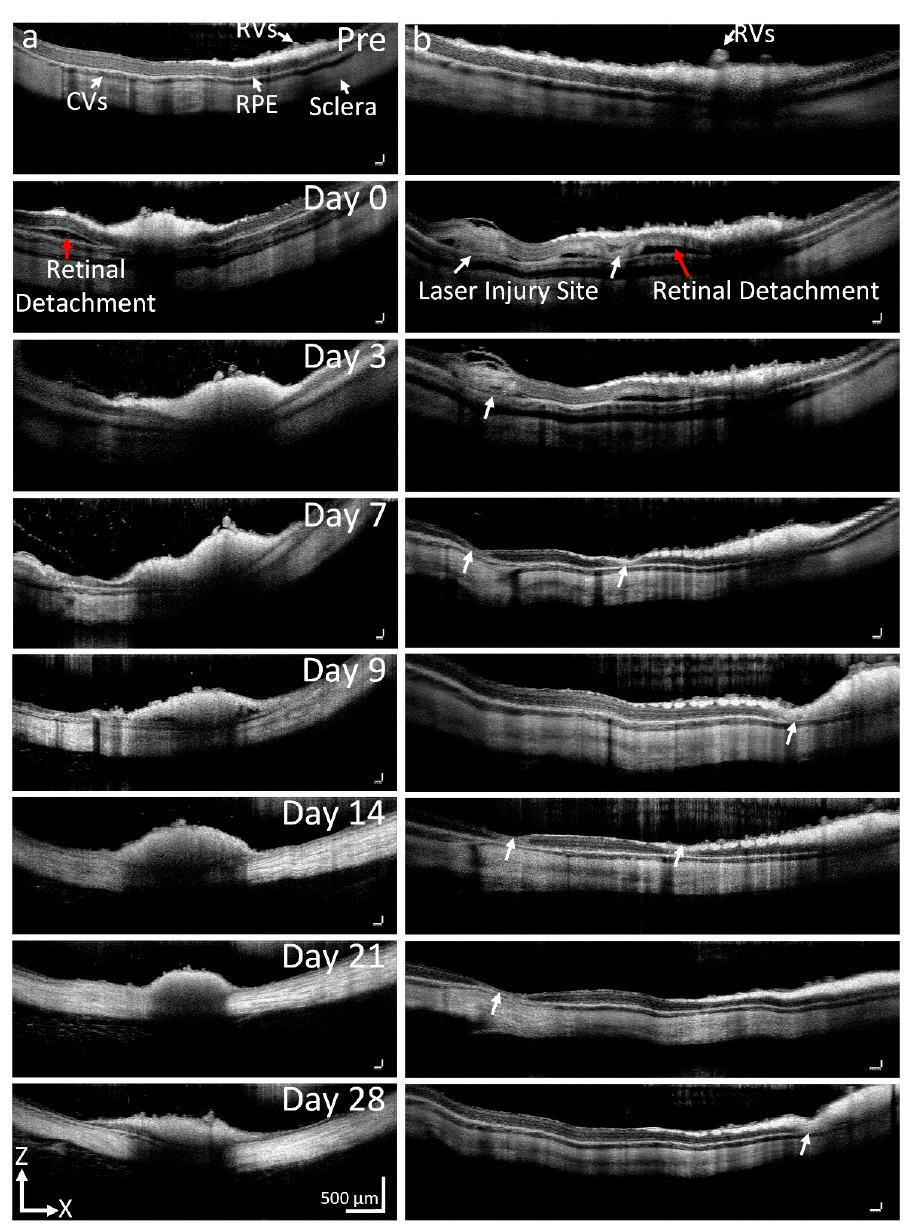
Figure 3. In vivo OCT imaging of RVO and CVO. ( a , b ) 2D OCT images acquired along the occluded retinal and choroidal vessels, respectively. Pre-laser treatment, retinal vessels (RVs), choroidal vessels (CVs), ganglion cell layer (GCL), retinal pigment epithelium (RPE), and sclera were clearly observed, and these layers are intact pre-laser. After laser illumination, retinal detachment was observed on both RVO and CVO (red arrows). White arrows show the area of retina affected by laser. No vascular recanalization was observed in both RVO and CVO rabbits.